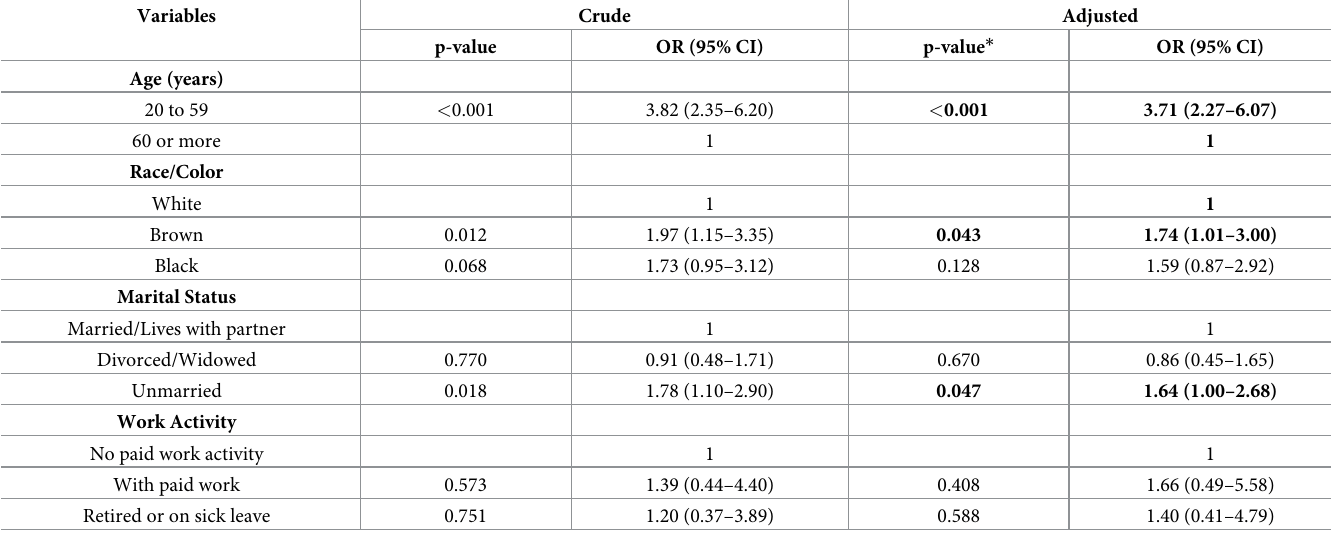
Table 2. Binary logistic regression between associated variables in the bivariate analysis and the outcome.